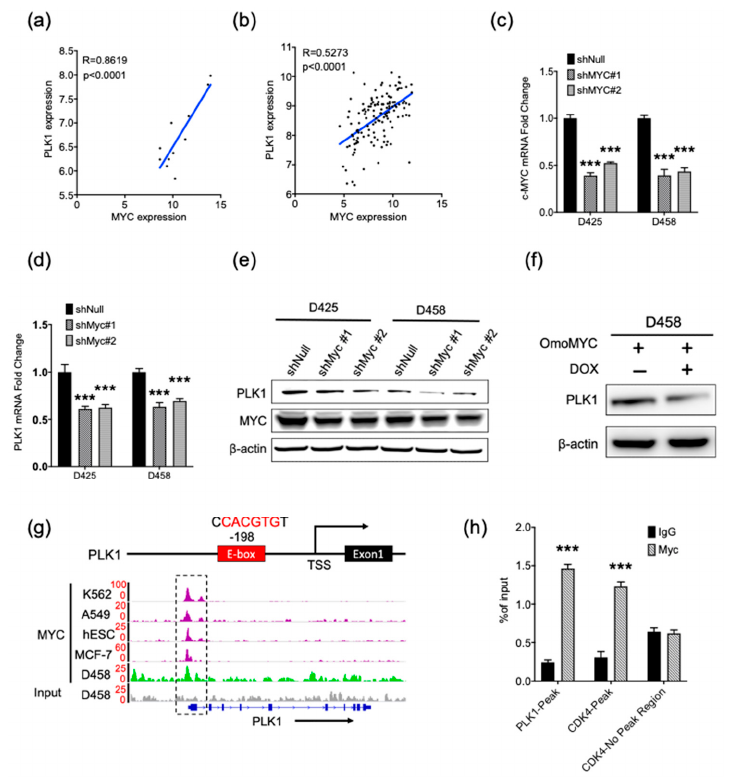
Figure 1. MYC activates polo-like kinase 1 ( PLK1 ) transcription in MYC-amplified medulloblastoma (MB) cell lines. ( a ) Correlation of mRNA levels between of PLK1 and MYC in 11 group 3 medulloblastoma (MB) patient samples from a microarray dataset of University of Colorado. ( b ) Correlation of mRNA levels between PLK1 and MYC in 134 group 3 MB patient samples of the Cavalli dataset [5]. ( c ) The real-time PCR analysis of c-MYC expression upon c-MYC shRNA knockdown for 72 h in the D425 and D458 cell lines; Mean ± SD; *** p < 0.001 (one-way ANOVA). ( d ) Real-time PCR analysis of PLK1 expression upon c-MYC shRNA knockdown for 72 h in the D425 and D458 cell lines; Mean ± SD; *** p < 0.001 (one-way ANOVA). ( e ) The immunoblot detection of c-MYC and PLK1 protein levels after 72 h of c-MYC shRNA transfection, with β -actin as a loading control. The quantification plot can be found in Figure S2a. ( f ) Induction of omoMYC in D458 cells were determined by Western blotting. Levels of PLK1 was determined by Western blot. β -actin was used as a loading control. The quantification plot can be found in Figure S2b. ( g ) E-box motif on promoter regions of PLK1 (top). IGV screenshot of representative chromatin immunoprecipitation (ChIP)-Seq data of c-MYC on the promotion of PLK1 . Data shown for the D458 cell lines from published studies (bottom). Genome-wide analyses of c-MYC occupancy demonstrated that c-MYC binds to the promoter region of PLK1 gene. A IgG isotype control was used for the control. K562: leukemia line; A549: lung carcinoma cell line; hESC: human embryonic stem cell lines; and MCF-7: breast cancer cell line. ( h ) Binding of c-MYC to the promoter of PLK1 analyzed by ChIP PCR in D458 cells. CDK4 -peak was used for the positive control. Mean ± SD; *** p < 0.001 (one-way ANOVA). The original blots are in Figure